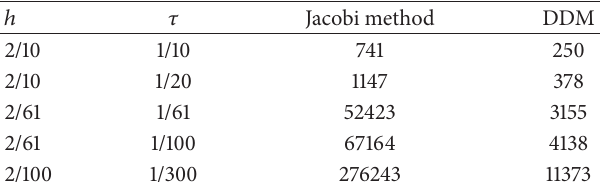
Table 2: Comparing Jacobi method and